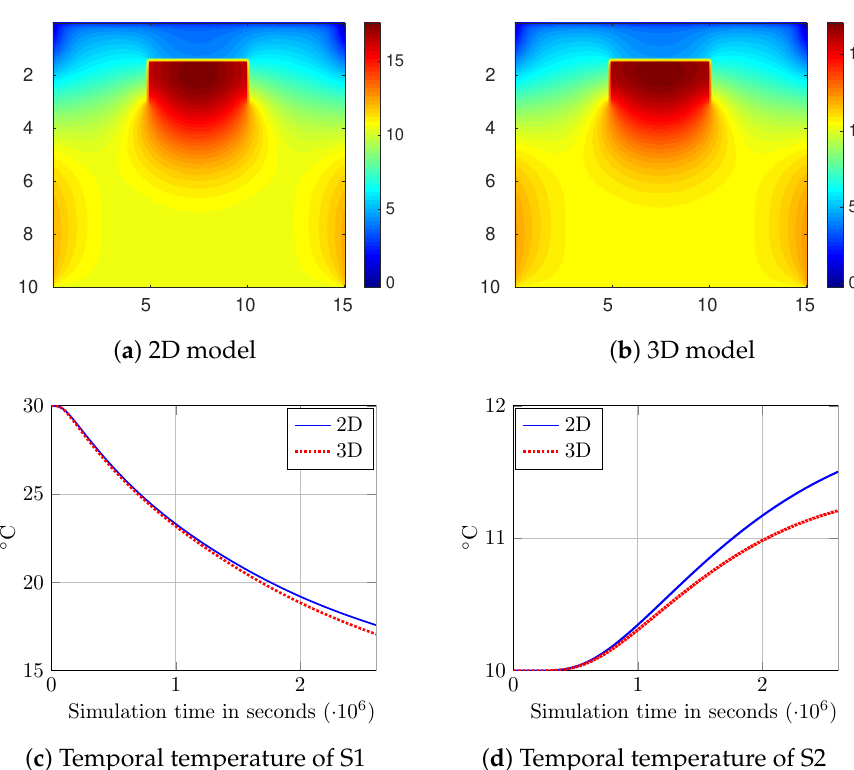
Figure 4. Results of the GES experiment without source: visual representation of the 2D and 3D solution at t F = 2.609 10 6 by applying the EE method for h = 0.04. ( a ) Result of the 2D model × after 6250 iterations with τ max,2D = 417.44. ( b ) Result of the 3D model after 9380 iterations with τ max,3D = 278.145, visualised in form of a cross-section along the middle of the 3D-GES. ( c ) Temporal temperature profile S1 fixed in the centre of the heat tank. ( d ) Temporal temperature profile S2 fixed in the centre between heat tank and bottom